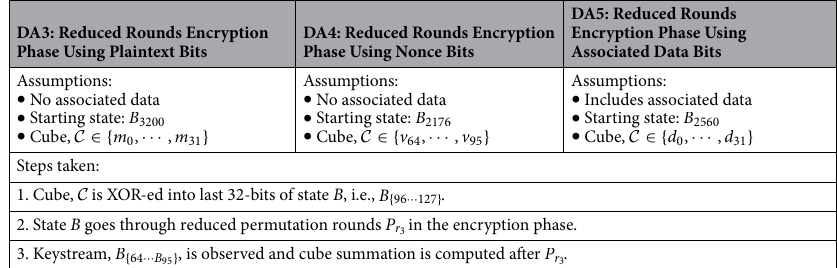
Table 9. Assumptions for DA3, DA4 and DA5.